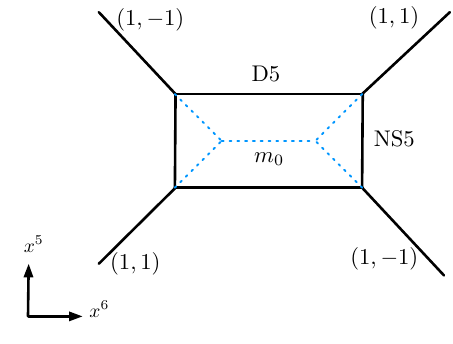
Figure 1 . A 5-brane web for the SU(2) 0 gauge